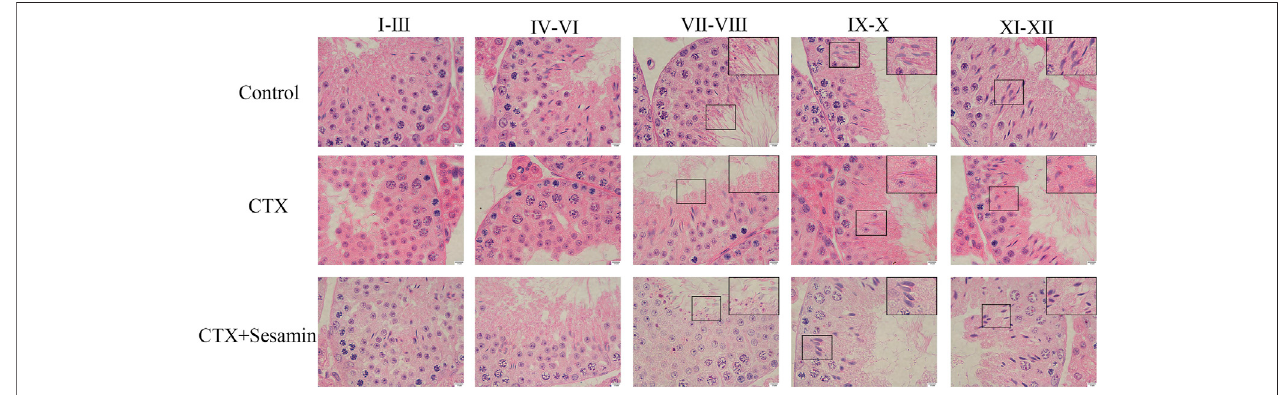
FIGURE 5 | Stages of seminiferous epithelium cycles determined by H&E staining. The representative H&E staining photomicrographs in the seminiferous epithelium cycles of the testis at 1,000 × magni fi cation (scale bar (cid:2) 10 μ m).